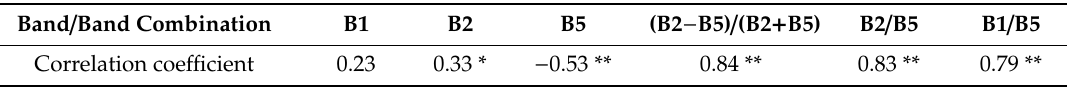
Table 3. The correlation coe ffi cient between the total phosphorus (TP) and band / band combination of MODIS.